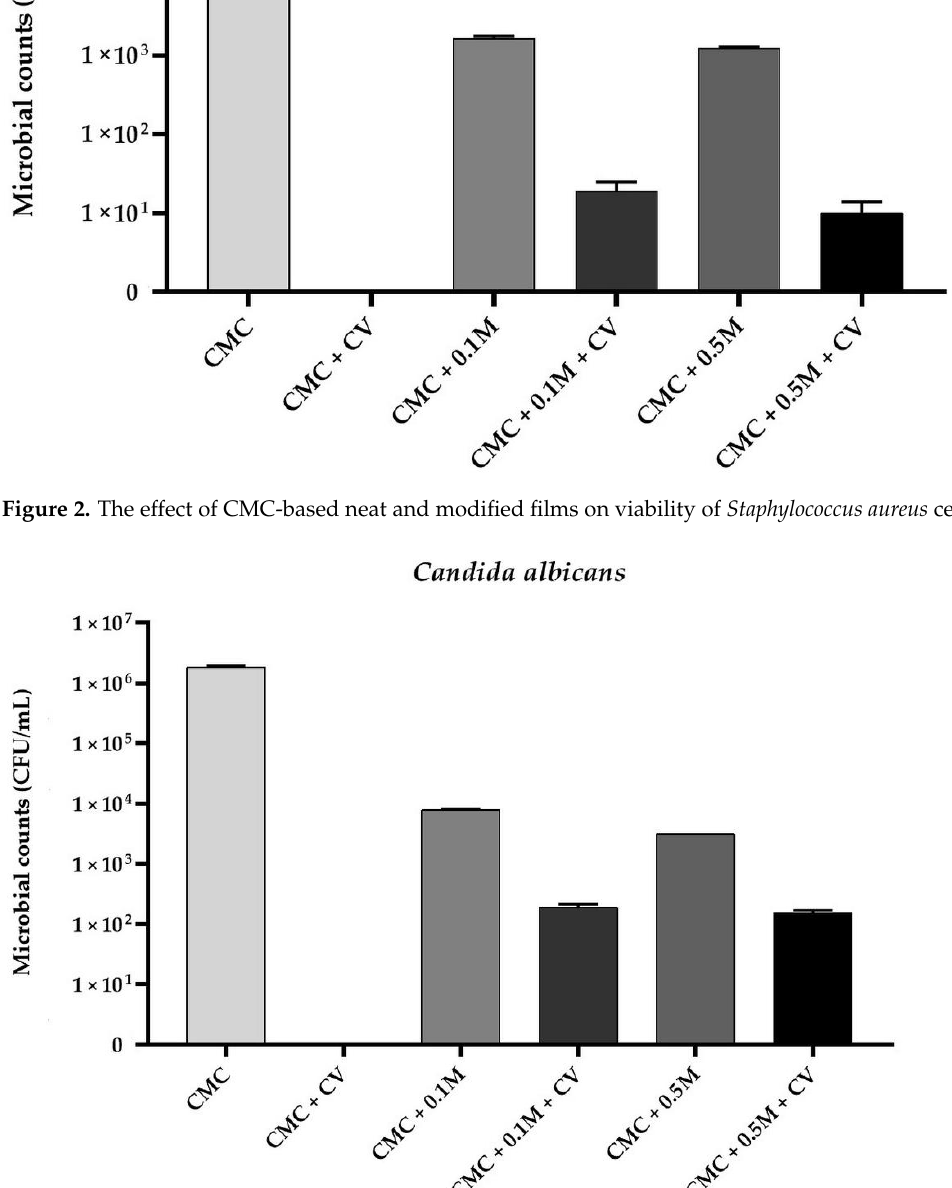
Figure 3. The effect of CMC-based neat and modified films on viability of Candida albicans cells.